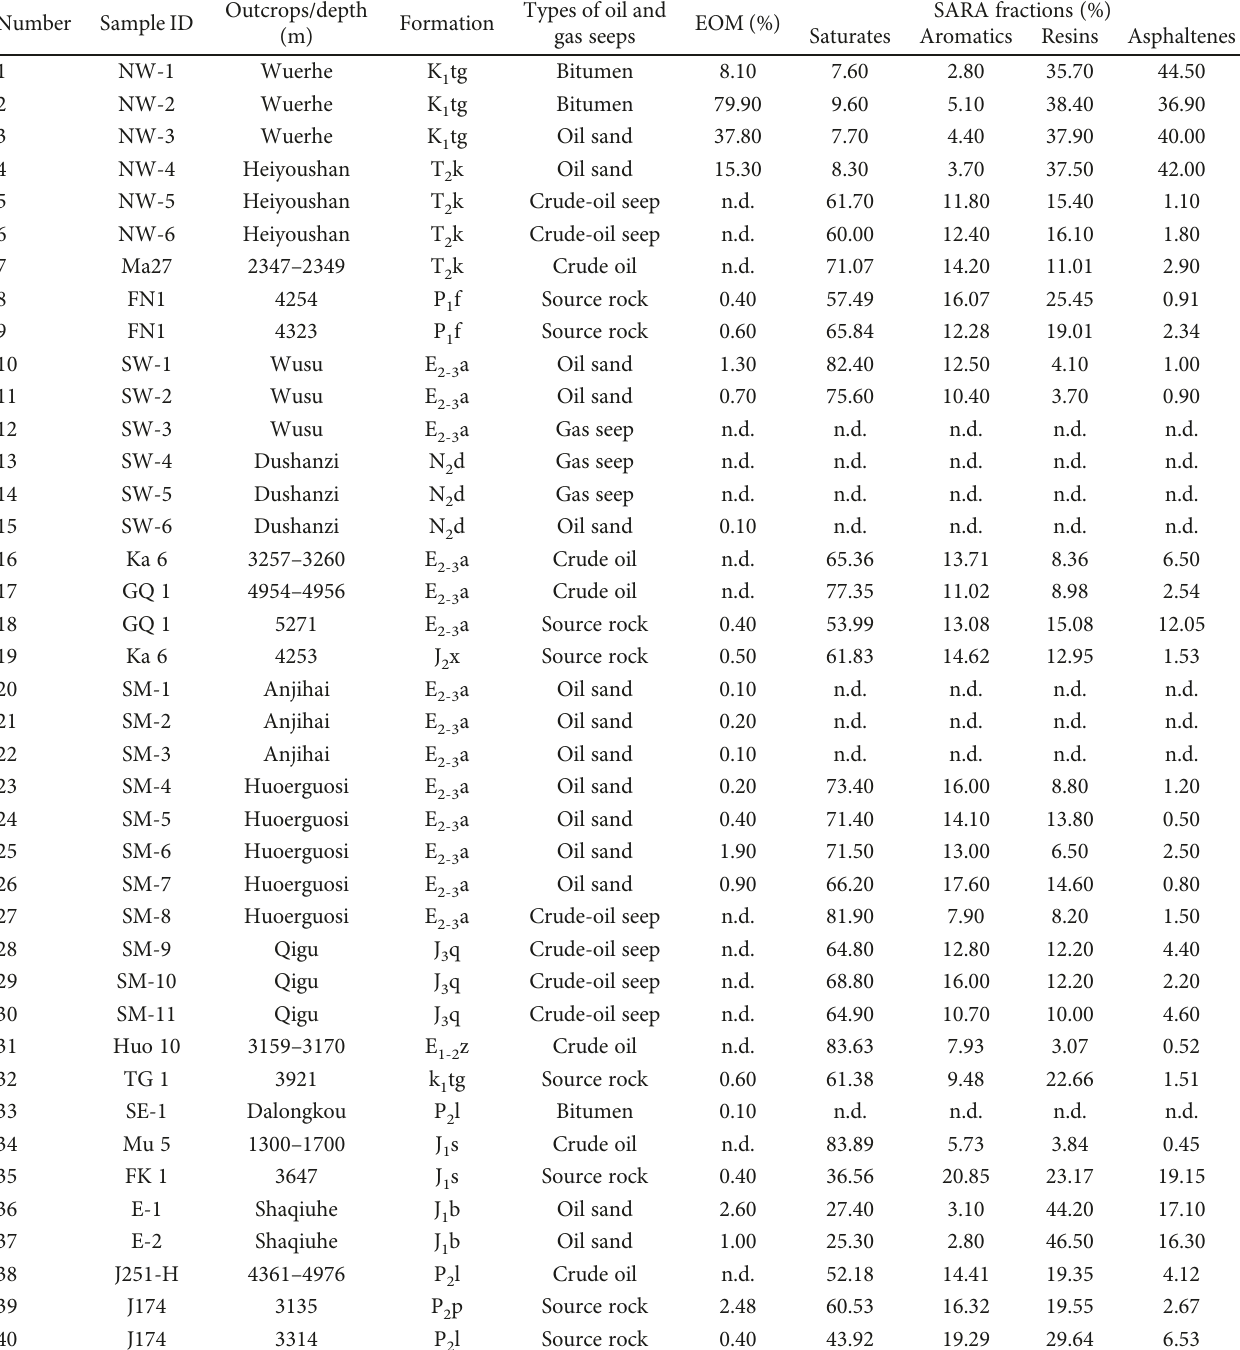
Table 1: Basic data of oil and gas seeps, selected crude oil, and source-rock samples from the Junggar